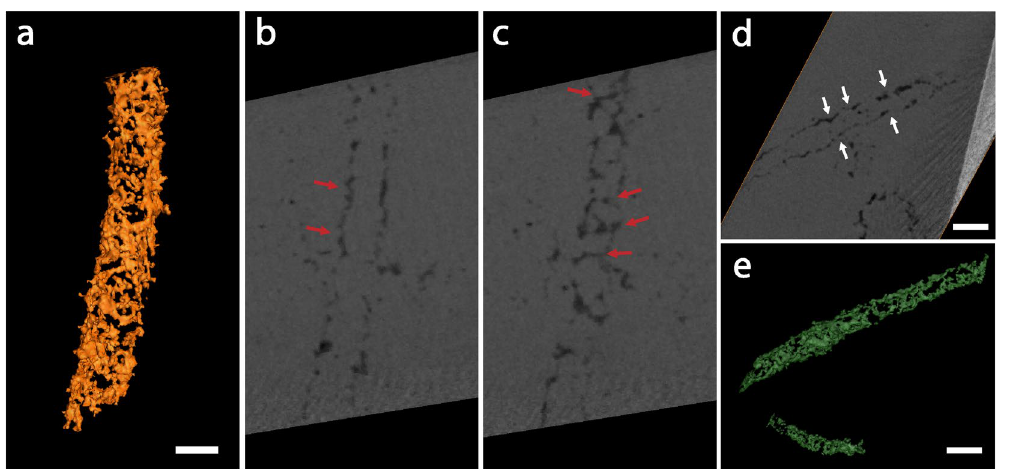
Figure 2. Selected filaments from the Schreiber Beach sample. ( a ) 3D rendering showing a discontinuous, irregular cell wall. ( b ) Detail of a longitudinal section from the center of the specimen showing an irregular cell wall morphology with saw-tooth-like morphology (red arrows), but no inner traces of septation. ( c ) Off- centered longitudinal section close to the border of the filament showing an inner “septa-like” pattern (red arrows) that in fact represents a taphonomic remobilization of sheath material. ( d ) Transversal 2D view of another filament showing periodic constrictions indicative of septation (white arrows) and ( e ) 3D rendering of this specimen. Note adjacent spheroidal microfossil in ( d) also showing the 2D saw-tooth pattern of carbonaceous material. Scale bars: 1 μ